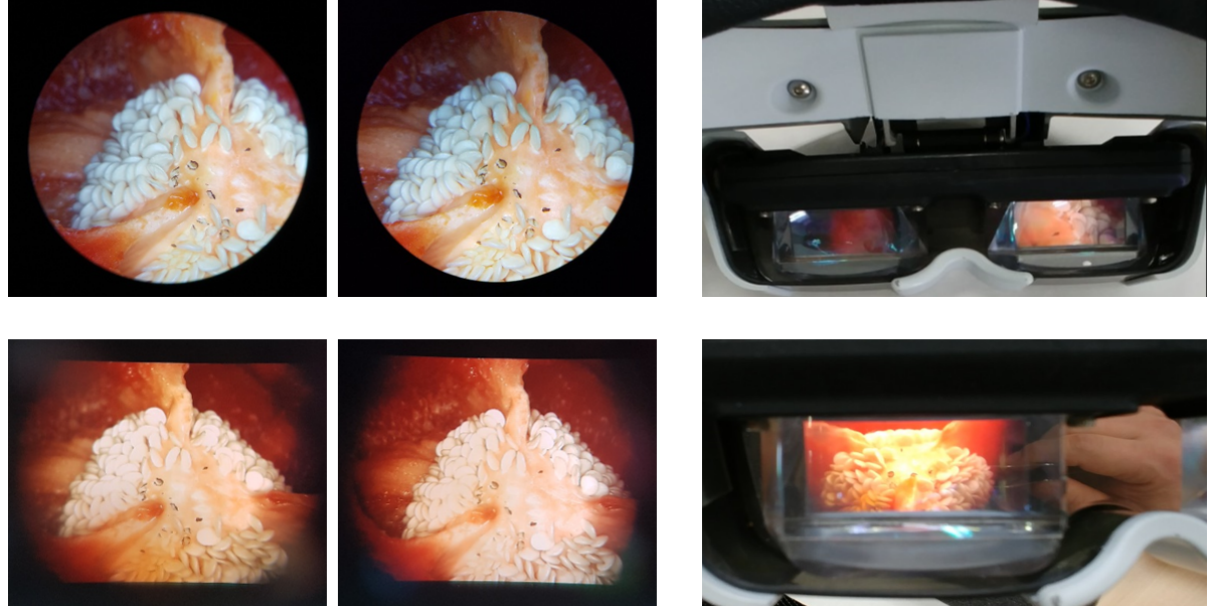
Figure 5. Top left: measured left and right images using eyepieces; bottom left: measured left and right images using head-mounted display (HMD); top and bottom right: a demonstration of the see-through type 3D